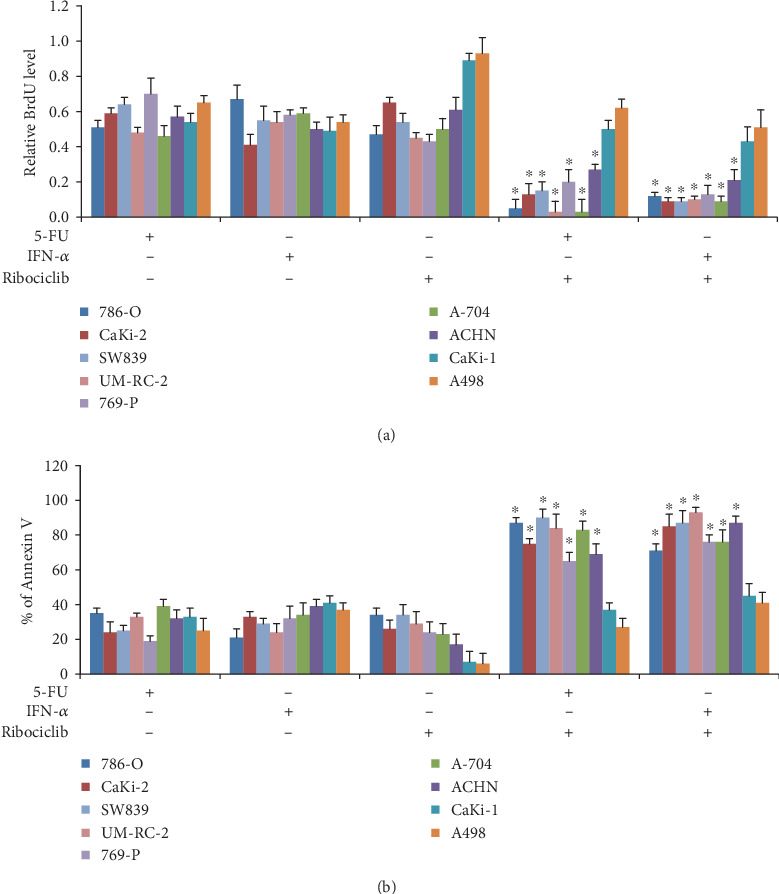
Ribociclib significantly enhances the in vitro efficacy of chemotherapy and immunotherapy in sensitive but not resistant RCC cell lines. Combination of ribociclib with 5-FU (chemotherapeutic agent) or IFN-α (immunotherapeutic agent) is significantly more effective in inhibiting proliferation (a) and inducing apoptosis (b) than 5-FU or IFN-α alone in sensitive but not resistant cell lines. Results shown in (a) are relative to control (value set as 1). 5-FU at 1 μM and IFN-α at 100 IU/ml were used in the combination assays in all tested RCC cell lines. Ribociclib at 0.1 μM in 786-O, CaKi-2, SW839, and UM-RC-2 cell lines, at 0.2 μM in 769-P, A-704, and ACHN, and at 0.8 μM in CaKi-1 and A498 cell lines was used for the proliferation assay. Ribociclib at 0.8 μM in 786-O, CaKi-2, SW839, and UM-RC-2 cell lines and at 1.6 μM in 769-P, A-704, ACHN, CaKi-1, and A498 cell lines was used for the apoptosis assay. ∗p < 0.05, compared to 5-FU or IFN-α alone.